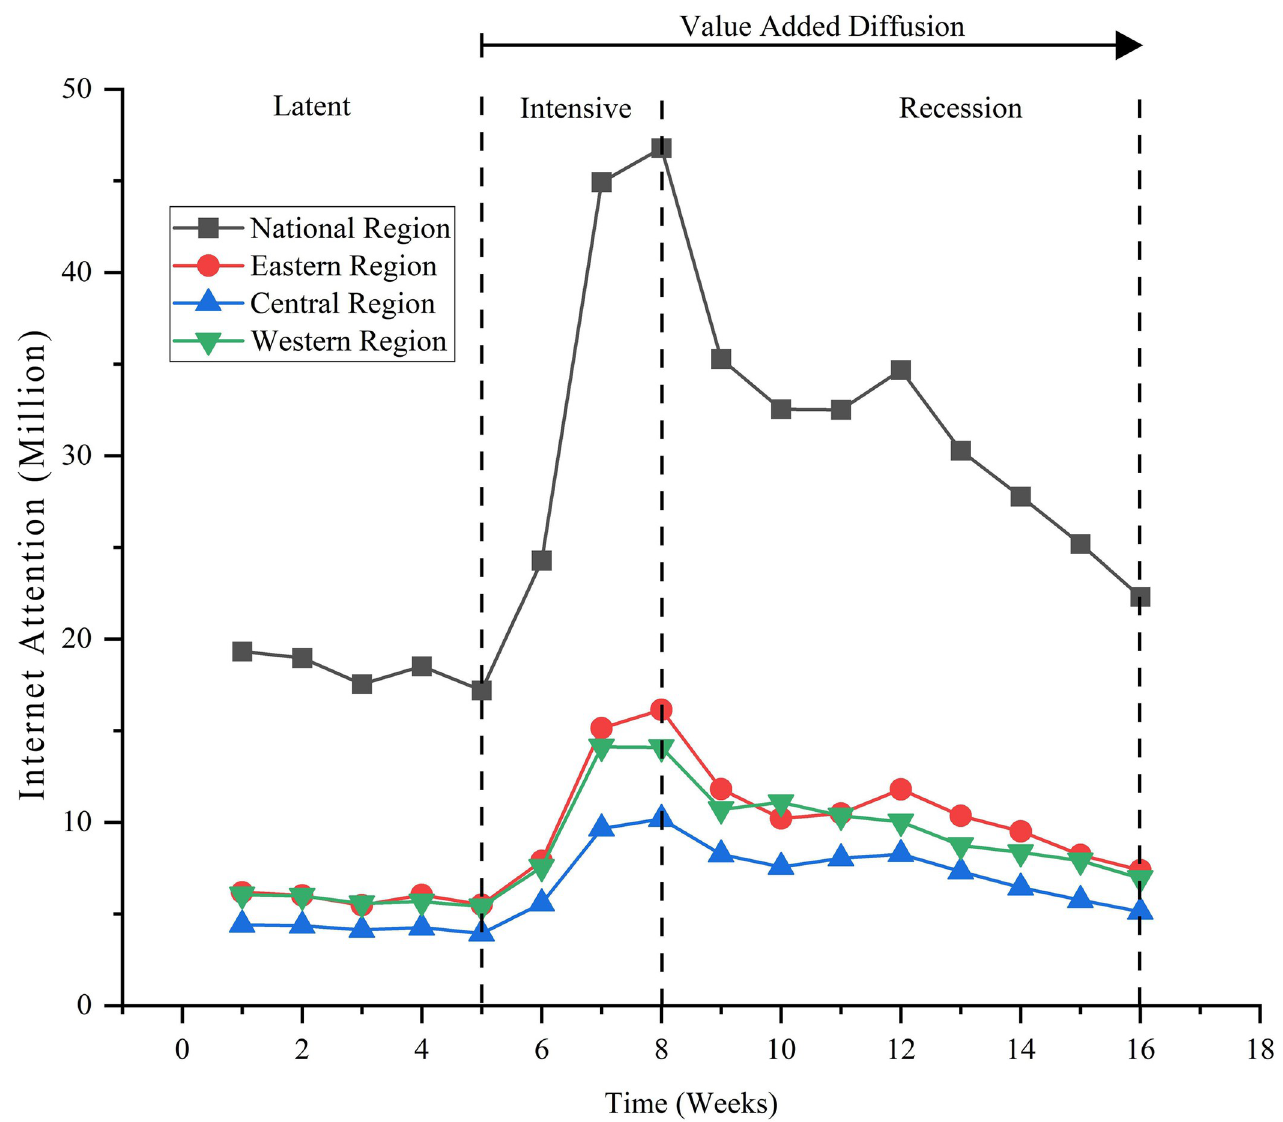
Fig 1. Time series evolution of internet attention nationwide and by region (East, Central and West